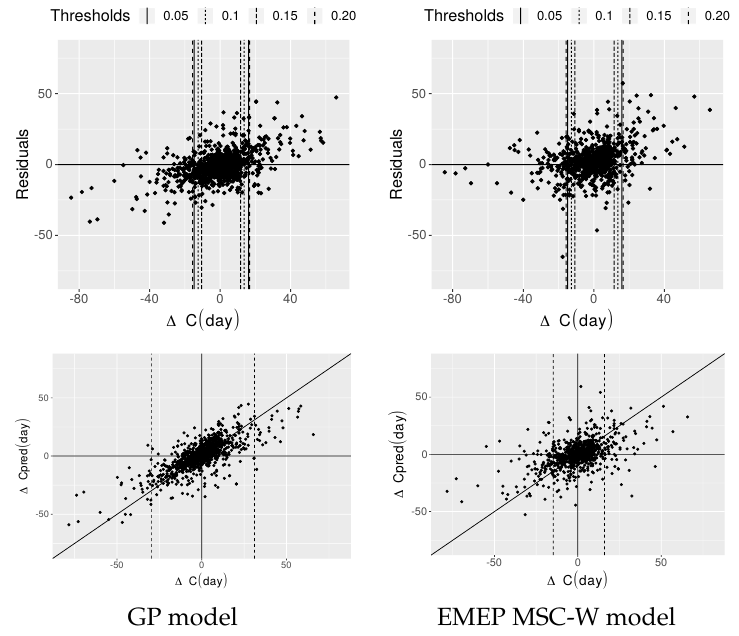
Figure 10. Plots on top show the residuals (GP and EMEP MSC-W models) against the observed change in PM 10 level in Ljubljana. Plots of ∆ C(2 days) against ∆ Cpred(2 days) (GP and EMEP MSC-W models) for PM 10 level in the lower of the plots for Ljubljana.